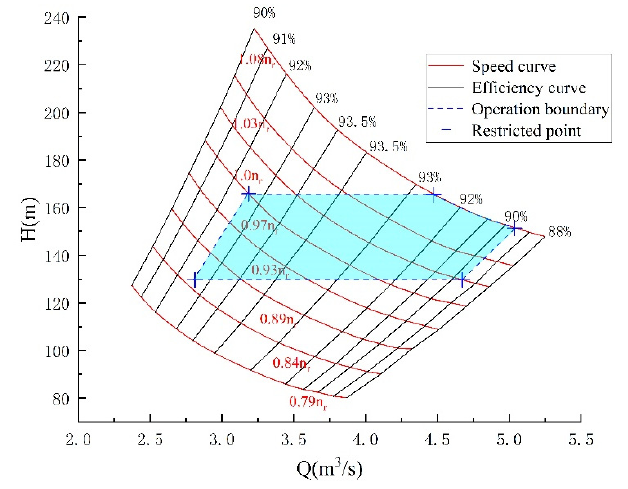
Figure 18. Regulation characteristics in generation mode.